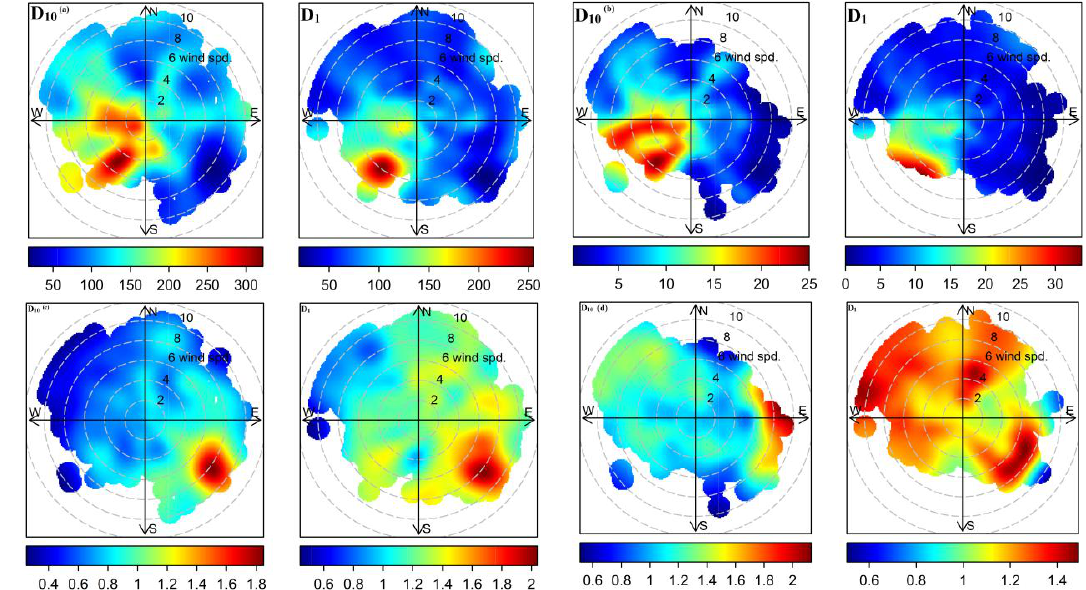
Figure 9. Bivariate plots of the scattering coefficient (a) , absorption coefficient (b) , scattering Ångström exponent (c) and absorption Ångström exponent (d) for D 10µm and D 1µm size